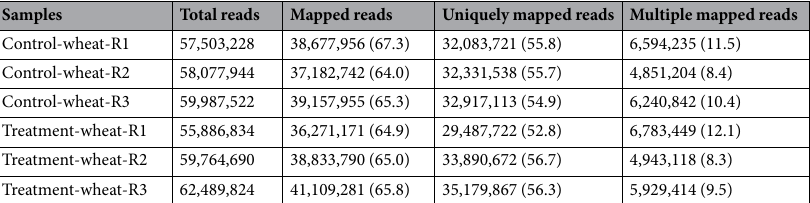
Table 1. Summary of read numbers aligned onto the wheat reference genome in the study. The number in brackets indicates the percentage of total reads aligned onto the wheat reference genome and/or matched at either unique or multiple genomic locations.